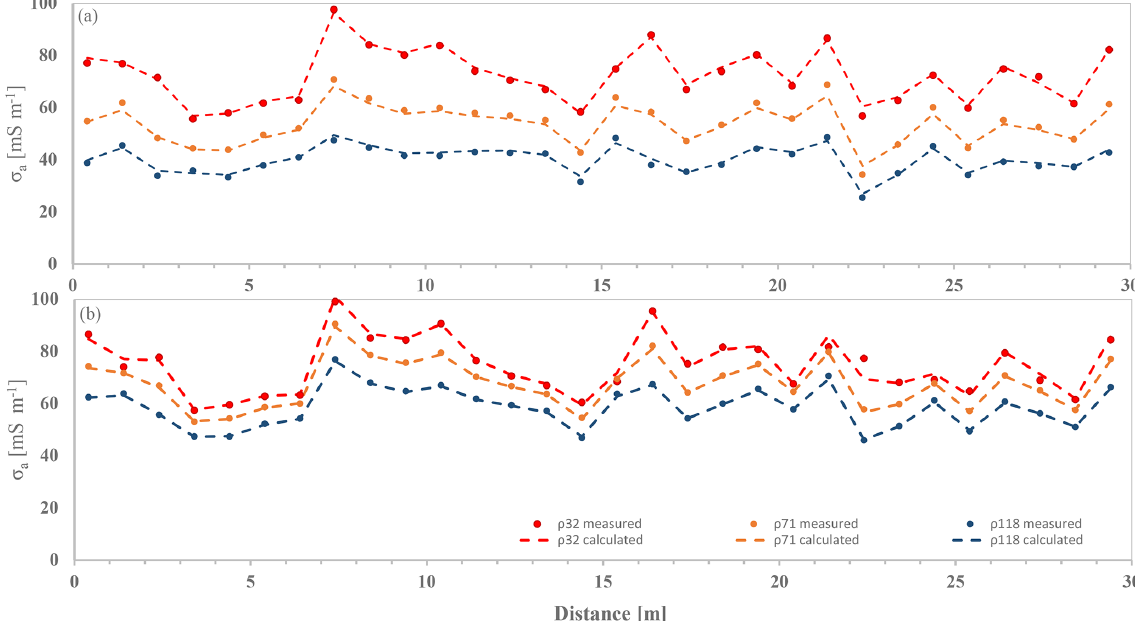
Figure 9. σ a data generated from the forward calculation of the σ b distributions on 23 November, shown in Fig. 8d. (a) HCP-mode and (b) VCP-mode configurations are